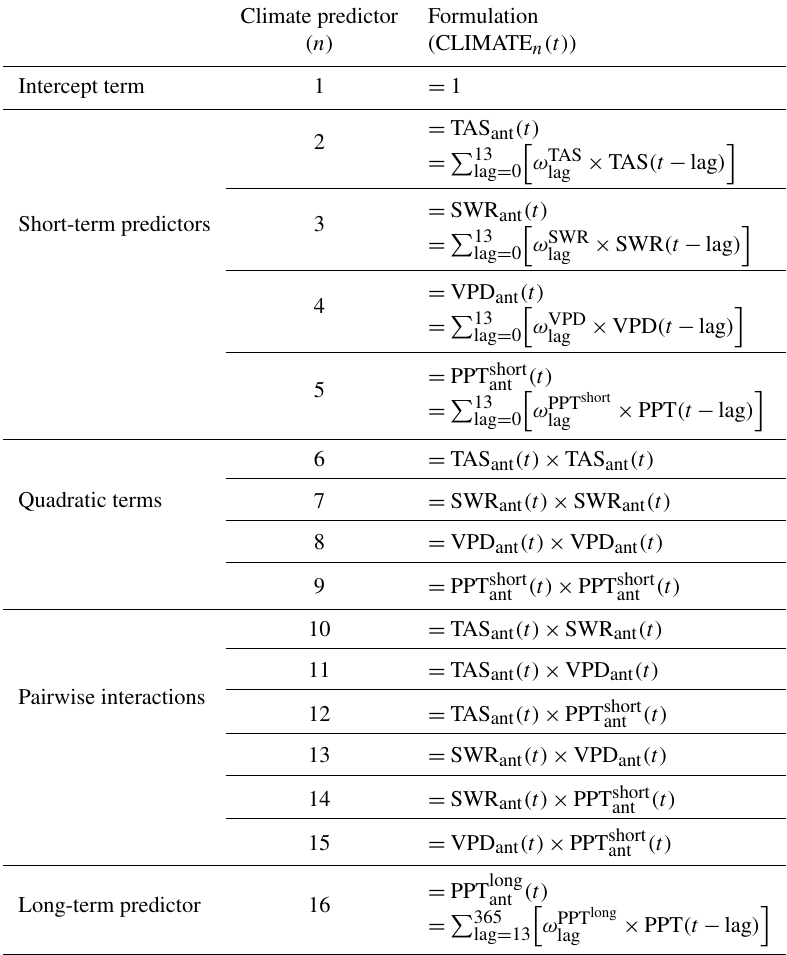
Table 2. Formulas for the CLIMATE n (t) term in the model for µ NEE (t) for each n . TAS is mean air temperature, SWR is incoming short- wave radiation, VPD is vapour pressure deficit, and PPT is rainfall. The lag term in the sums is in days; i.e. at lag = 3, TAS( t − lag) is the mean air temperature from 3d prior. Note that the lags in PPT long ant are larger periods than the daily lags for the short-term predictors, and PPT is here taken as the mean daily rainfall in these lagged periods; ω CLIM is the weight assigned to each lag period and is different for each lag of the five climate